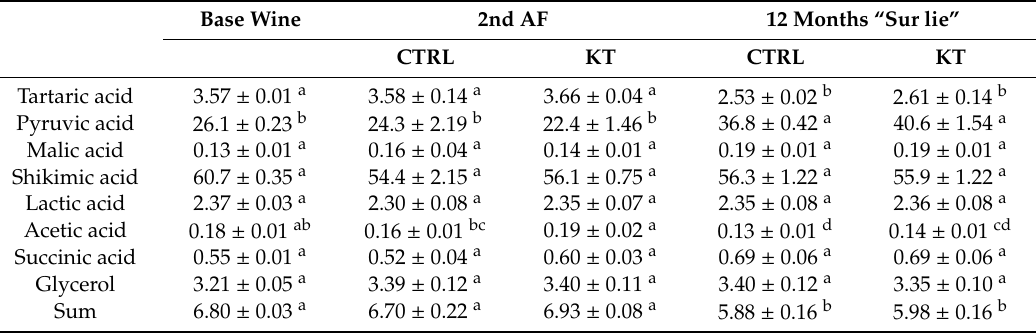
Table 2. Organic acids and glycerol amounts (g / L) after secondary alcoholic fermentation (2nd AF) and after 12 months of storage “sur lie” (shikimic and pyruvic acids as mg / L). In the same row, di ff erent letters indicate significant di ff erences according to Tukey’s test ( p < 0.05). n =